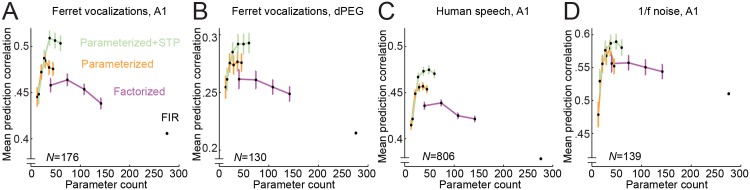
Comparison of model architectures across brain areas and stimulus domains.
A. Pareto plot summarizes performance of the FIR, factorized, parameterized and parameterized-STP models for A1 vocalization data. Error bars indicate SEM for the difference from performance by the FIR STRF, as in Fig 4C. B. Comparison of model performance for vocalization data recorded in ferret belt auditory cortex (dPEG), plotted as in A. Overall performance is lower than in A1, but performance rankings are the same: D = 2 factorized > FIR model (p < 0.001, sign test), D = 3 parameterized > D = 2 factorized model (p < 0.01), D = 3 parameterized-STP > D = 3 parameterized model (p < 0.001). Thus results of the model comparison generalize across areas in the auditory processing hierarchy. C. Comparison of model performance for human speech data recorded in A1. The parameterized-STP models again show the strongest performance with successive significant improvements for each model architecture (p < 0.001, sign test, for all comparisons), indicating that the results generalize across different natural stimuli. D. Comparison of model performance for 1/f noise data recorded in A1. The models again show the same pattern of relative performance, indicating that the results also generalize to synthetic noise stimuli.